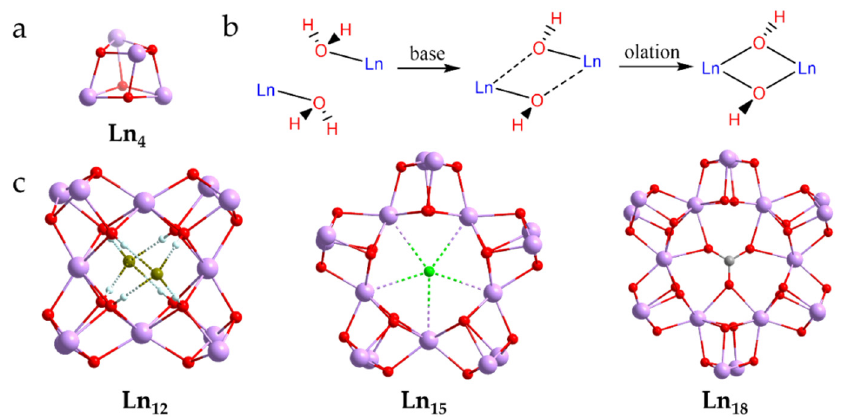
Figure 1. ( a ) The structures of building units [Ln 4 ( µ 3 -OH) 4 ] 8+ . ( b ) The key step of ligand-controlled hydrolysis of Ln 3+ ions [19]. ( c ) Templated anions I − , Cl − , and CO 3 2 − in Ln 12 , Ln 15 , and Ln 18 , respectively. Color legends: Ln, lavender; O, red; I, dark yellow; H, light turquoise; Cl, green; C, gray [21,22].